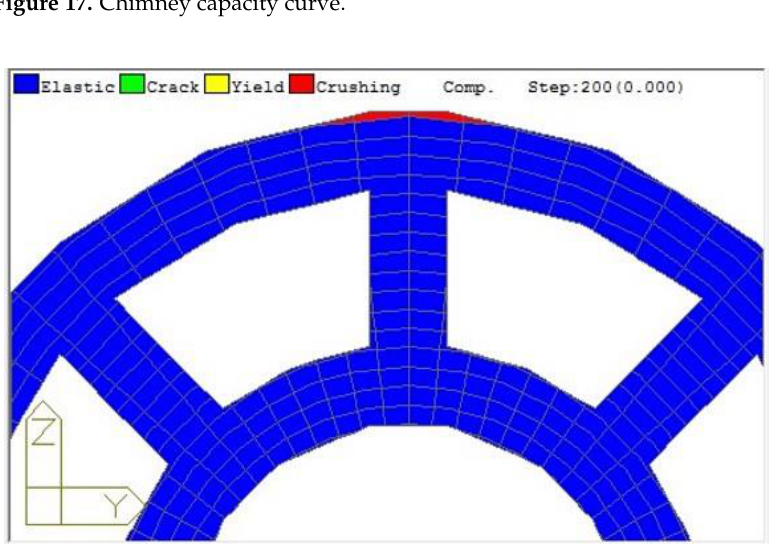
Figure 17. Chimney capacity curve.